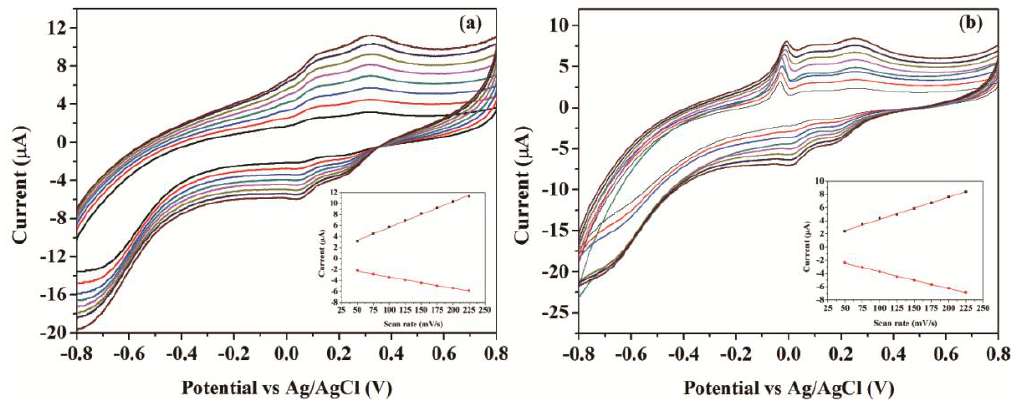
Figure 4. CVs of ( a ) CNFs/Lac/Nafion/GCE and ( b ) Cu/CNFs/Lac/Nafion/GCE in 0.1 M, pH 4.0, acetate buffer solutions at scan rates from the inner to the outer: 50, 75, 100, 125, 150, 175, 200, 225 mV/s. Insets: calibration plots of anodic and cathodic peak currents vs. scan